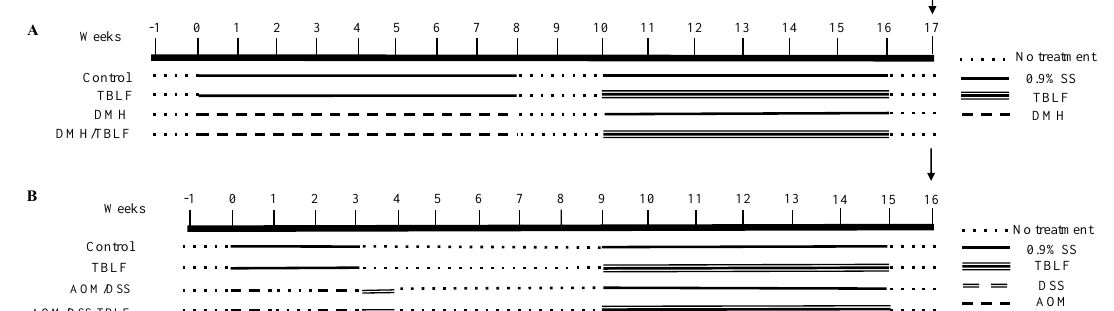
Figure 10. Experimental design. ( A ) DMH experiment ( n = 10 per group). ( B ) AOM/DSS experiment ( n = 7 per group). Two independent experiments were performed. Cancer induction with DMH was achieved after eight weeks of treatment to generate colon tumorigenesis while AOM induction took two weekly doses to generate aberrant cryptic foci. TBLF was administered for six weeks each third day and sacrificed a week later (black